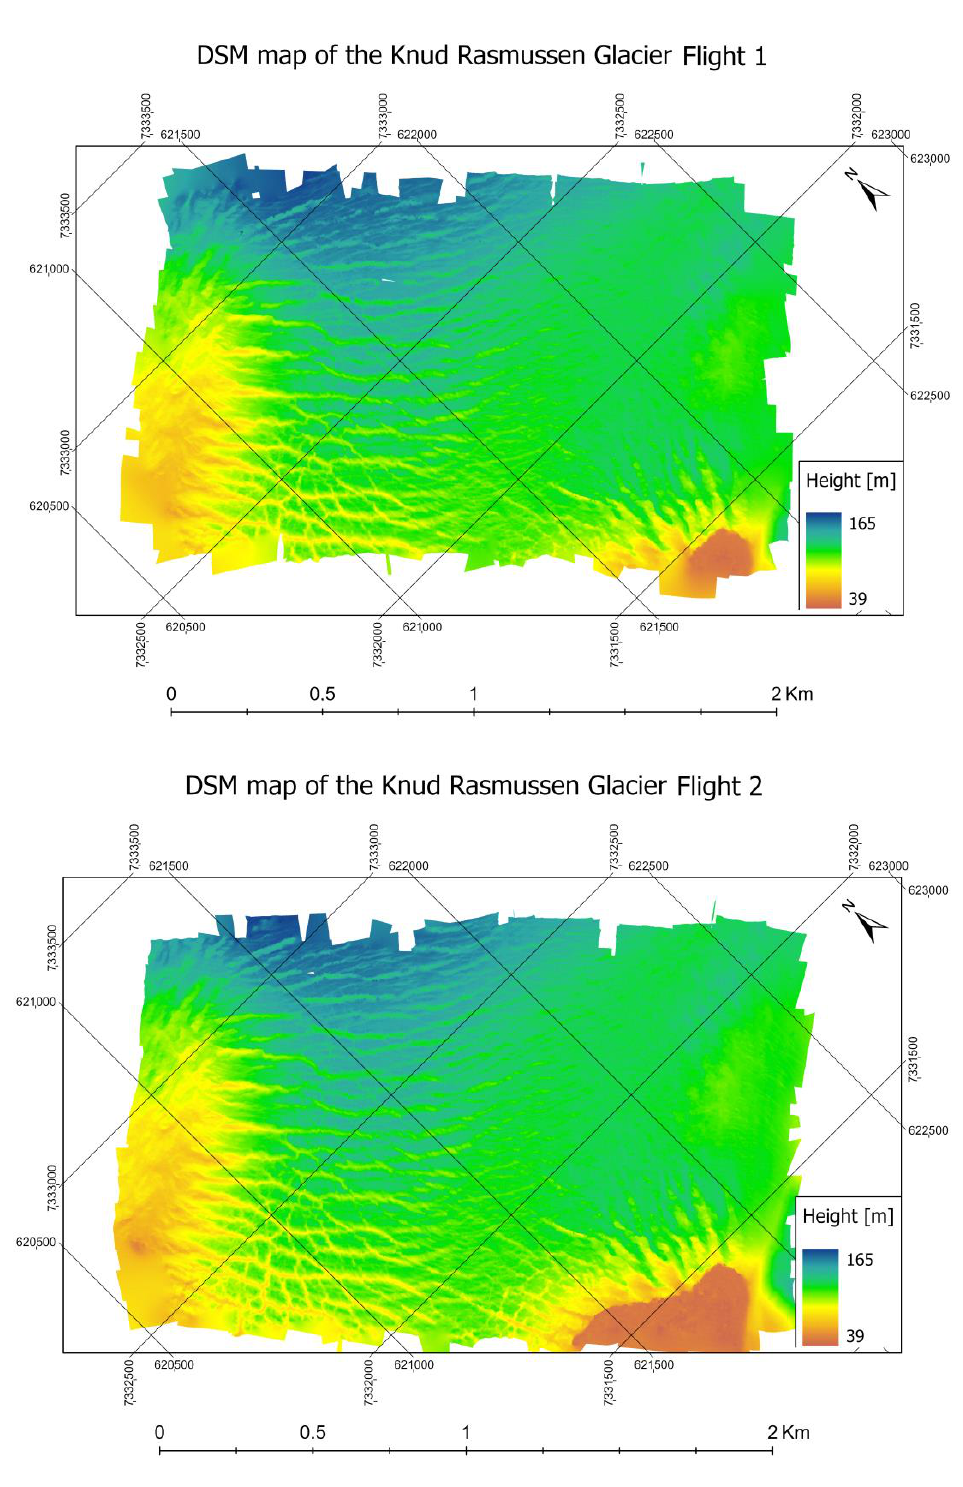
Figure 11. Flight no.1 and no.2—digital surface model